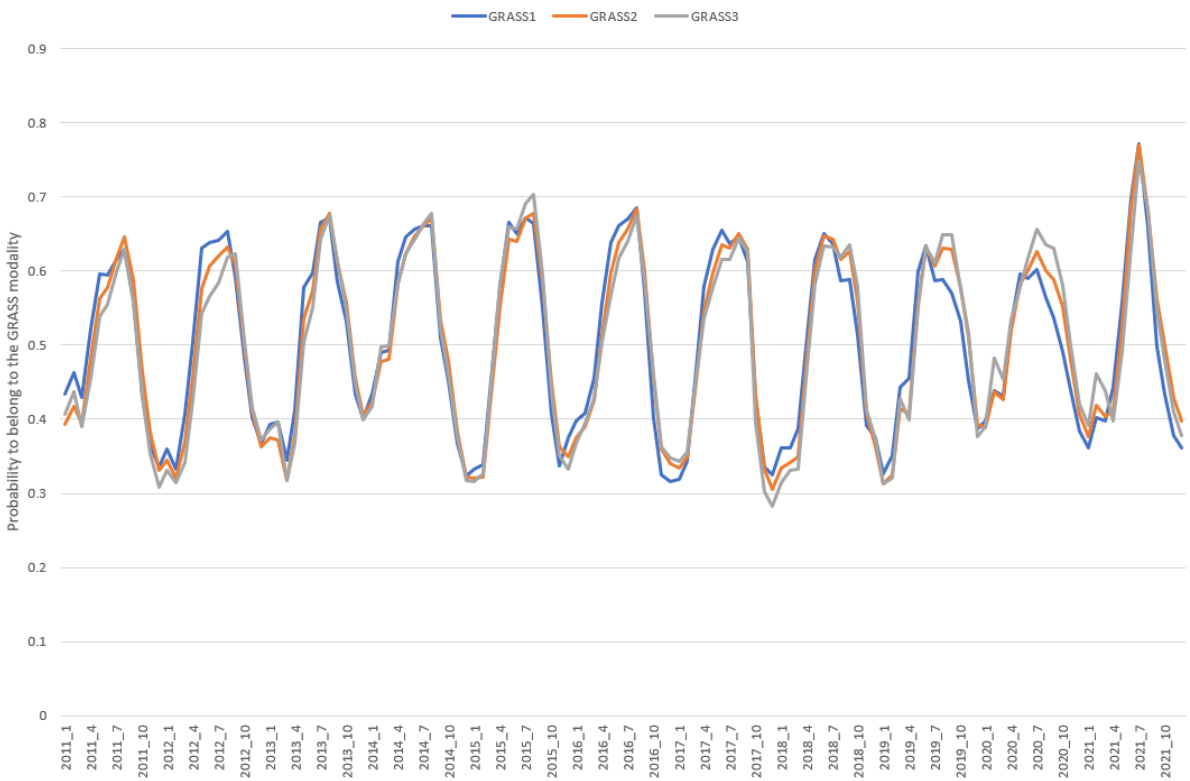
Figure 5. Evolution of the probability of belonging to the GRASS modality for the 11 studied years based on the validation set (N = 2,365,113 records).